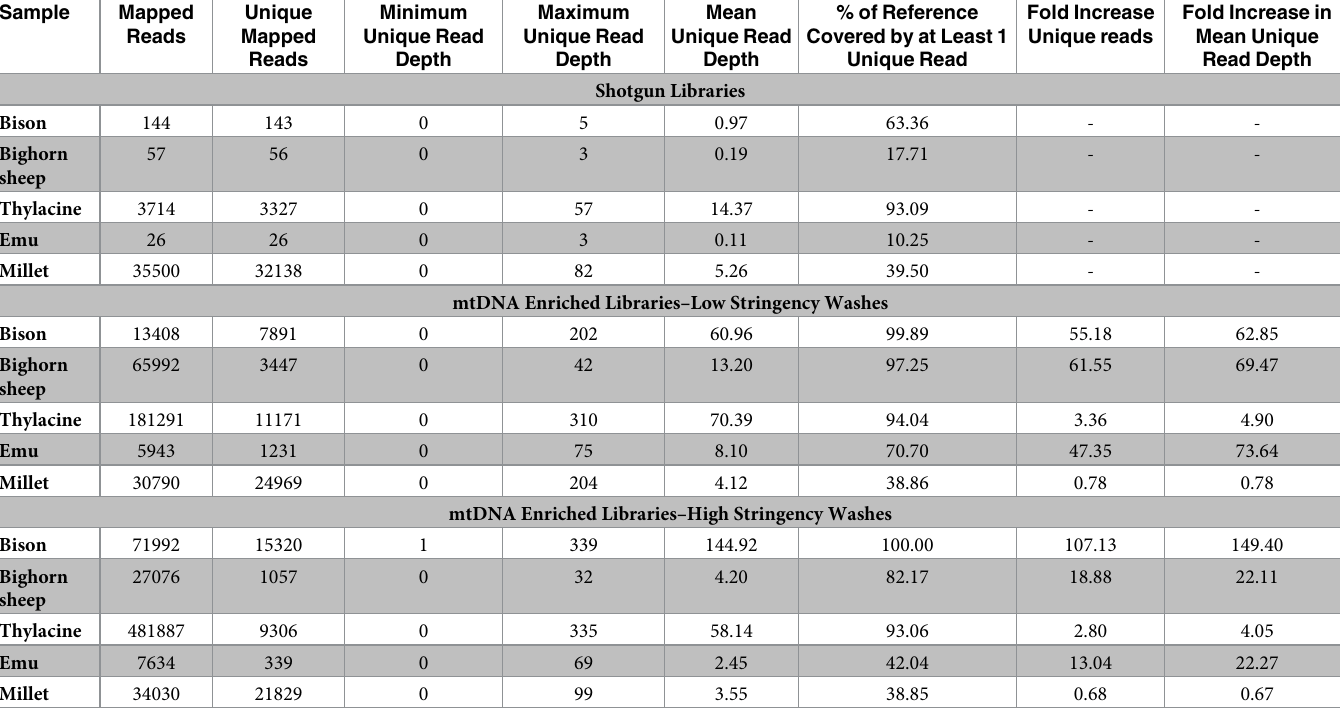
Table 5. Mapping statistics for subsampled divergent taxa